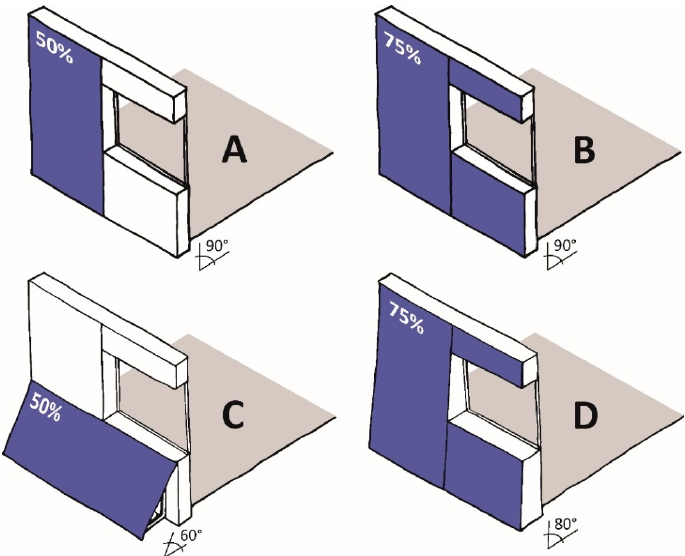
Figure 5. Scenarios considered in the assessment, combining array size and panel tilt possibilities. Table 7. Reference COP values for solar array and solar cooling systems used in the assessment.